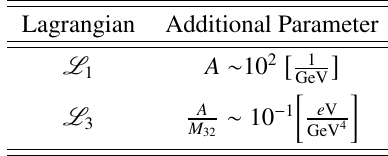
and our additional parameter must lie in this range. 32 m 2 Here we define M 32 ≡ m 2 3 2